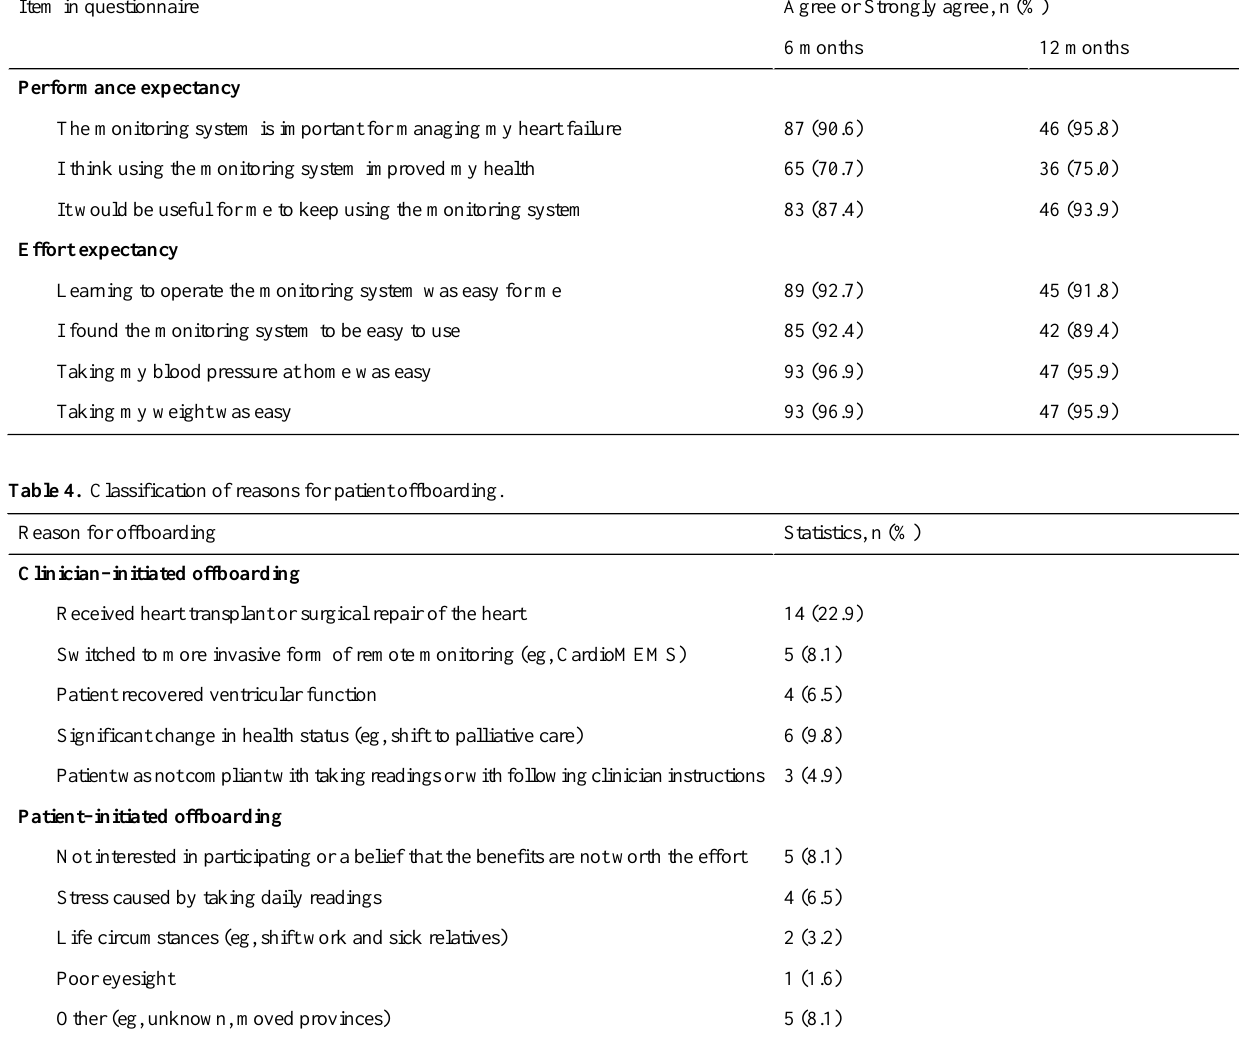
Agree or Strongly agree, n (%)Item in questionnaire